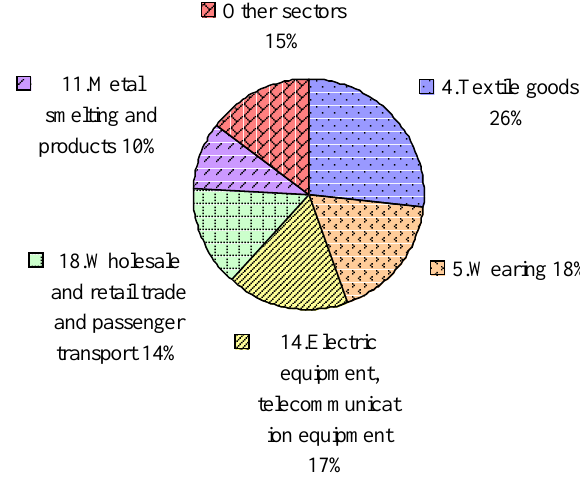
Fig. 1. Shares of the major net virtual water exporting sectors in Figure 1. Shares of the major net virtual water exporting sectors in total net virtual total net virtual water export water export (2002)